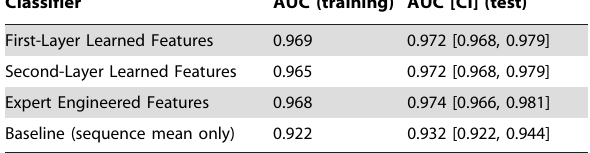
Table 3. Unsupervised features were as powerful as expert- engineered features in distinguishing uric acid sequences from gout vs.